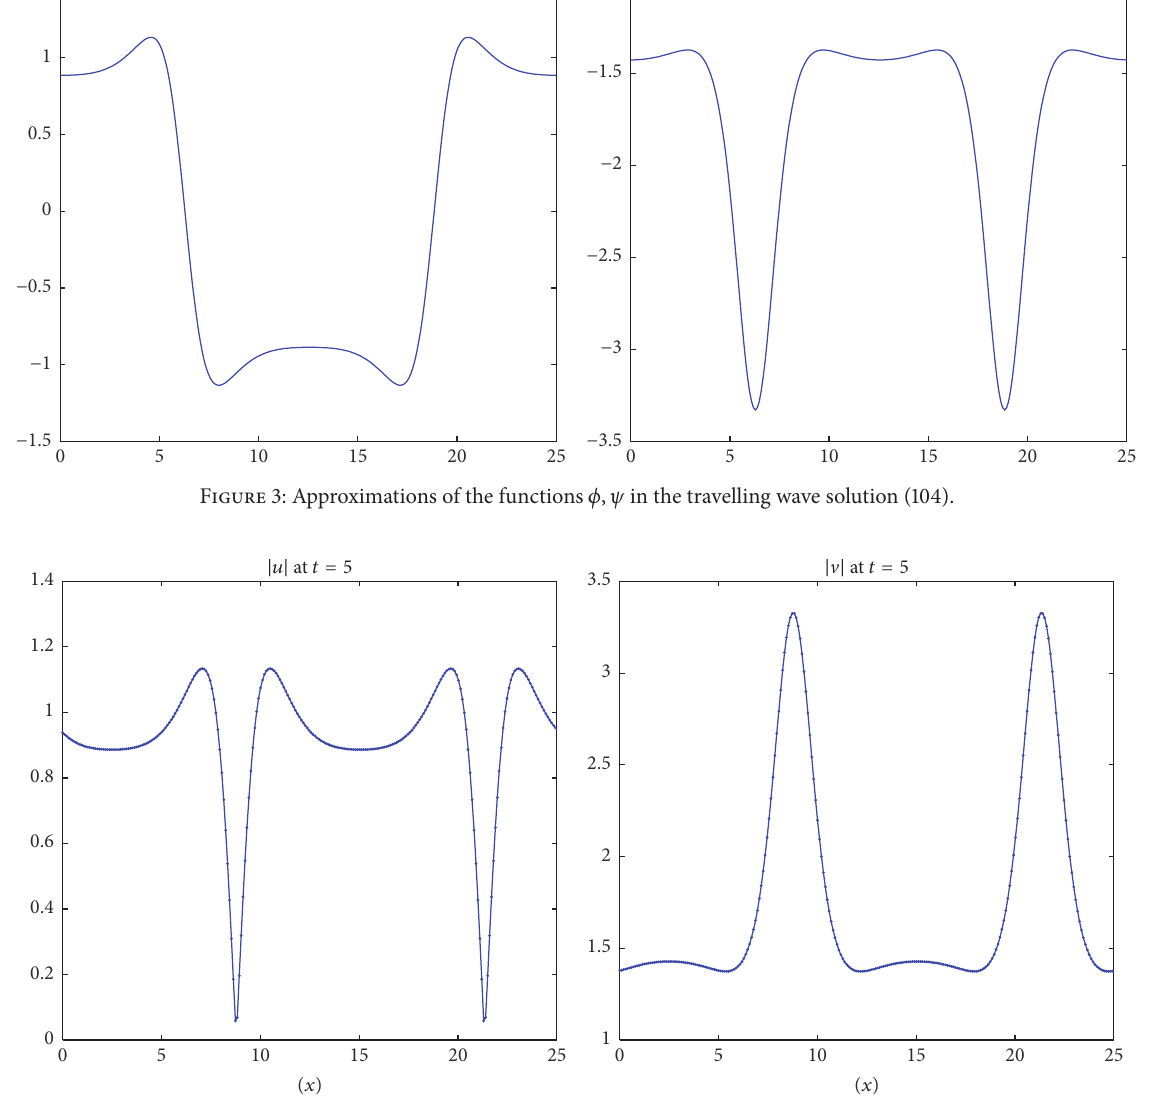
Figure 4: Evolution of a travelling wave solution of the SBO system at 𝑡 = 5 . In solid line, |𝑢| , | V | computed with the numerical solver (57). In pointed line, |𝑢| , | V | for the approximate travelling wave solution